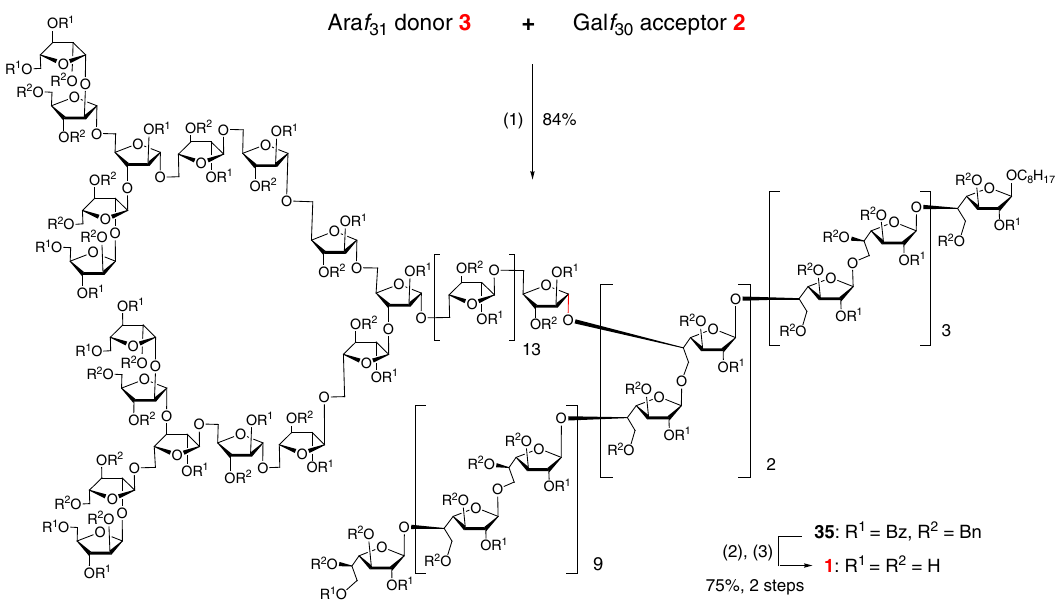
Figure 4 | Assembly of arabinogalactan 1. Reagents and conditions: (1) BSM, Tf 2 O, 4Å MS, CH 2 Cl 2 , (cid:2) 40 (cid:2) C; (2) NaOCH 3 , CH 3 OH/THF (2:1); (3) Pd/C, H 2 , EtOAc/THF/1-PrOH/H 2 O (2:1:1:1). BSM, benzenesulfinyl